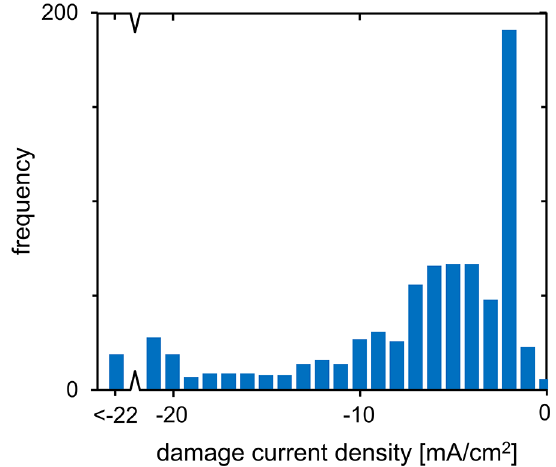
Fig. 5. Histogram of damage current density in dark reverse bias sweeps for all samples. The last bin (most left) represents the total number of cells with a damage current density smaller than (cid:1) 22mA/cm 2